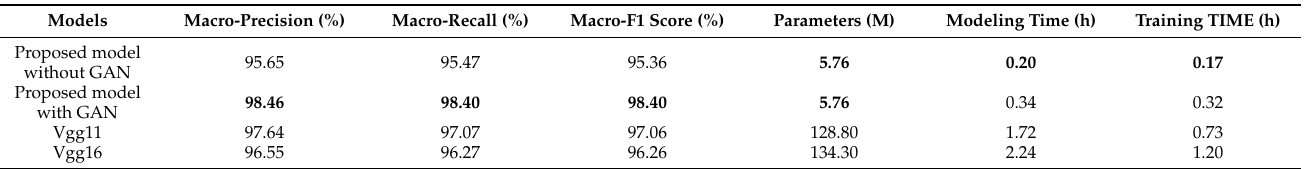
Table 9. Summary of model